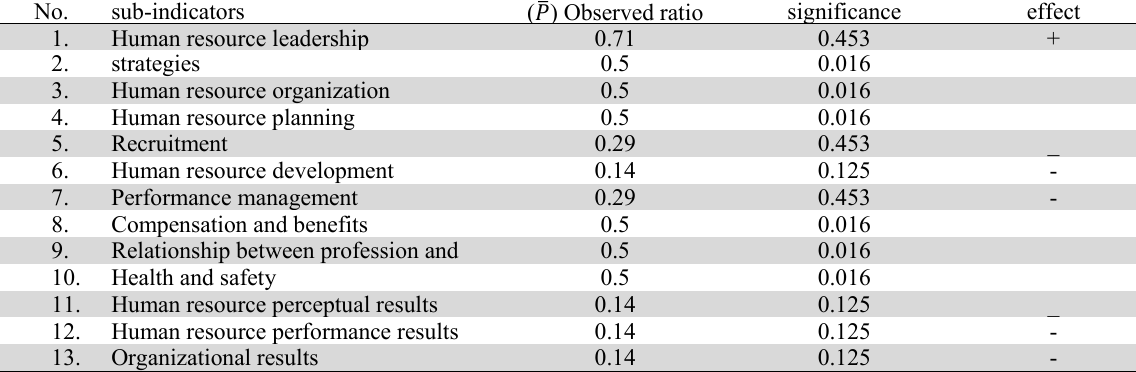
Evaluation of strengths and weaknesses of the organization No.